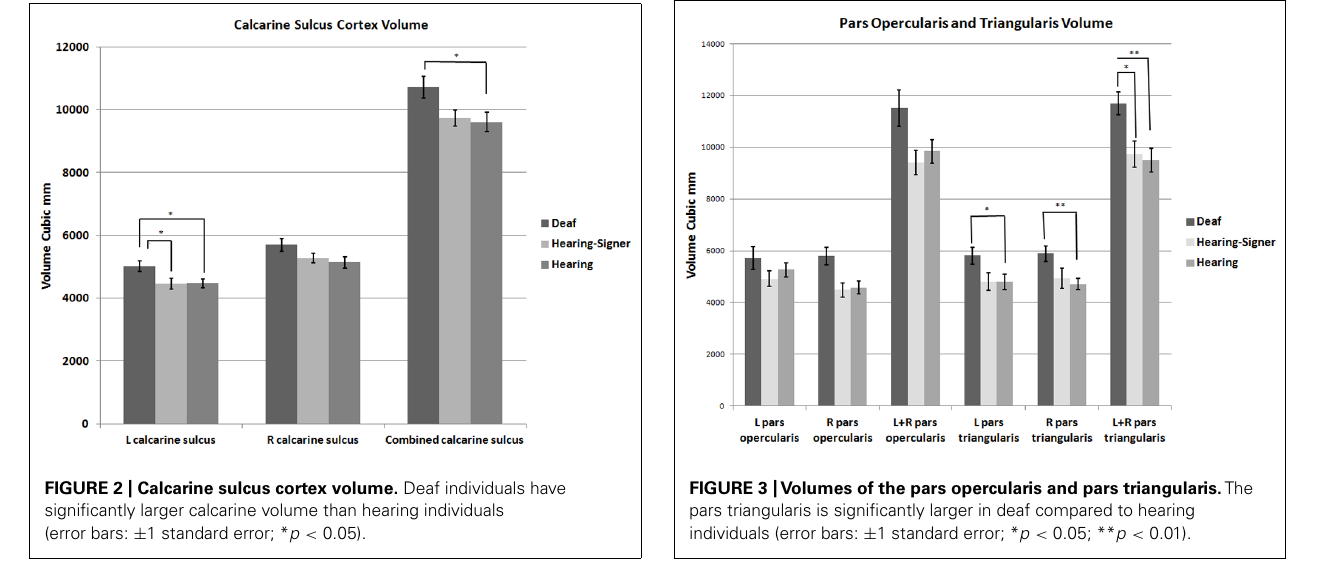
Hearing non-signers